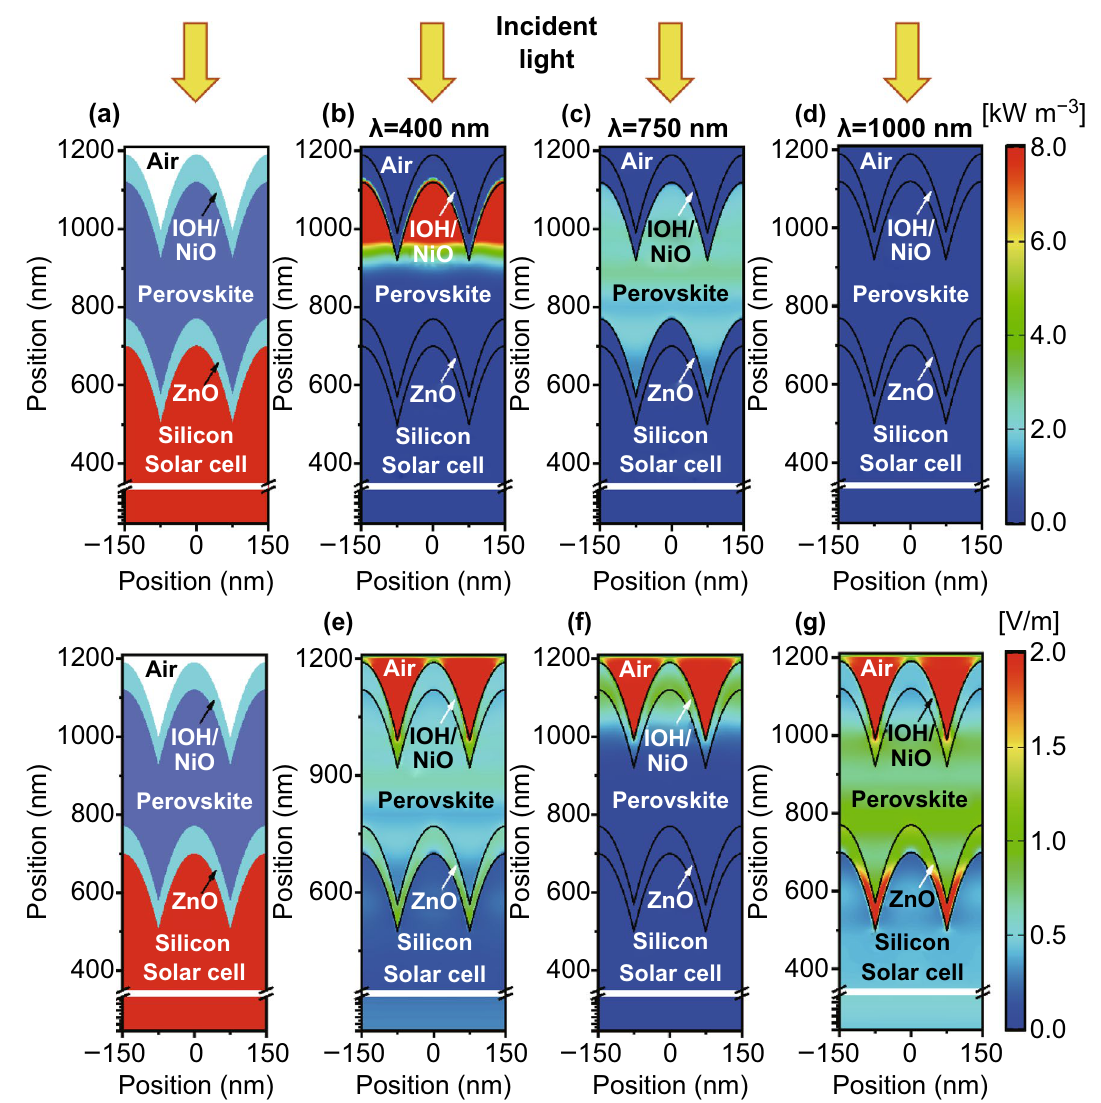
Fig. 14 a Cross section of moth eye textured perovskite/silicon tandem solar cell. Power density map for incident wavelength of b 400 nm, c 750 nm, and d 1000 nm. Electric field distribution map for incident wavelength of e 400 nm, f 750 nm, and g 1000